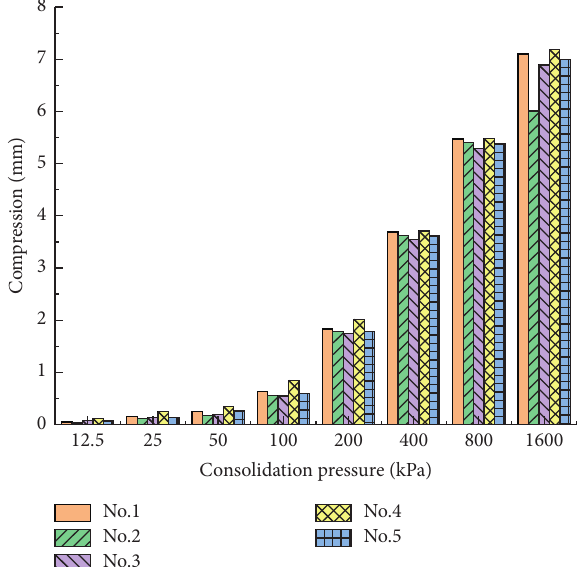
Figure 1: Investigated compression